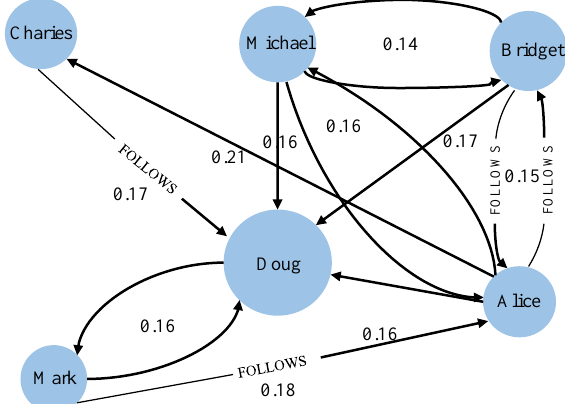
Figure 3. A relationship diagram of microgrid users. The direction of the arrow indicates the transmission direction of electricity. For example, “Charies −→ Doug” denotes that Charies can transmit electricity to Doug but Doug cannot transmit electricity to Charies, because there is no arrow going from Doug to Charies. “Mark ←− −→ Doug” indicates that they can transmit electricity to each other because there are two-way arrows between them.